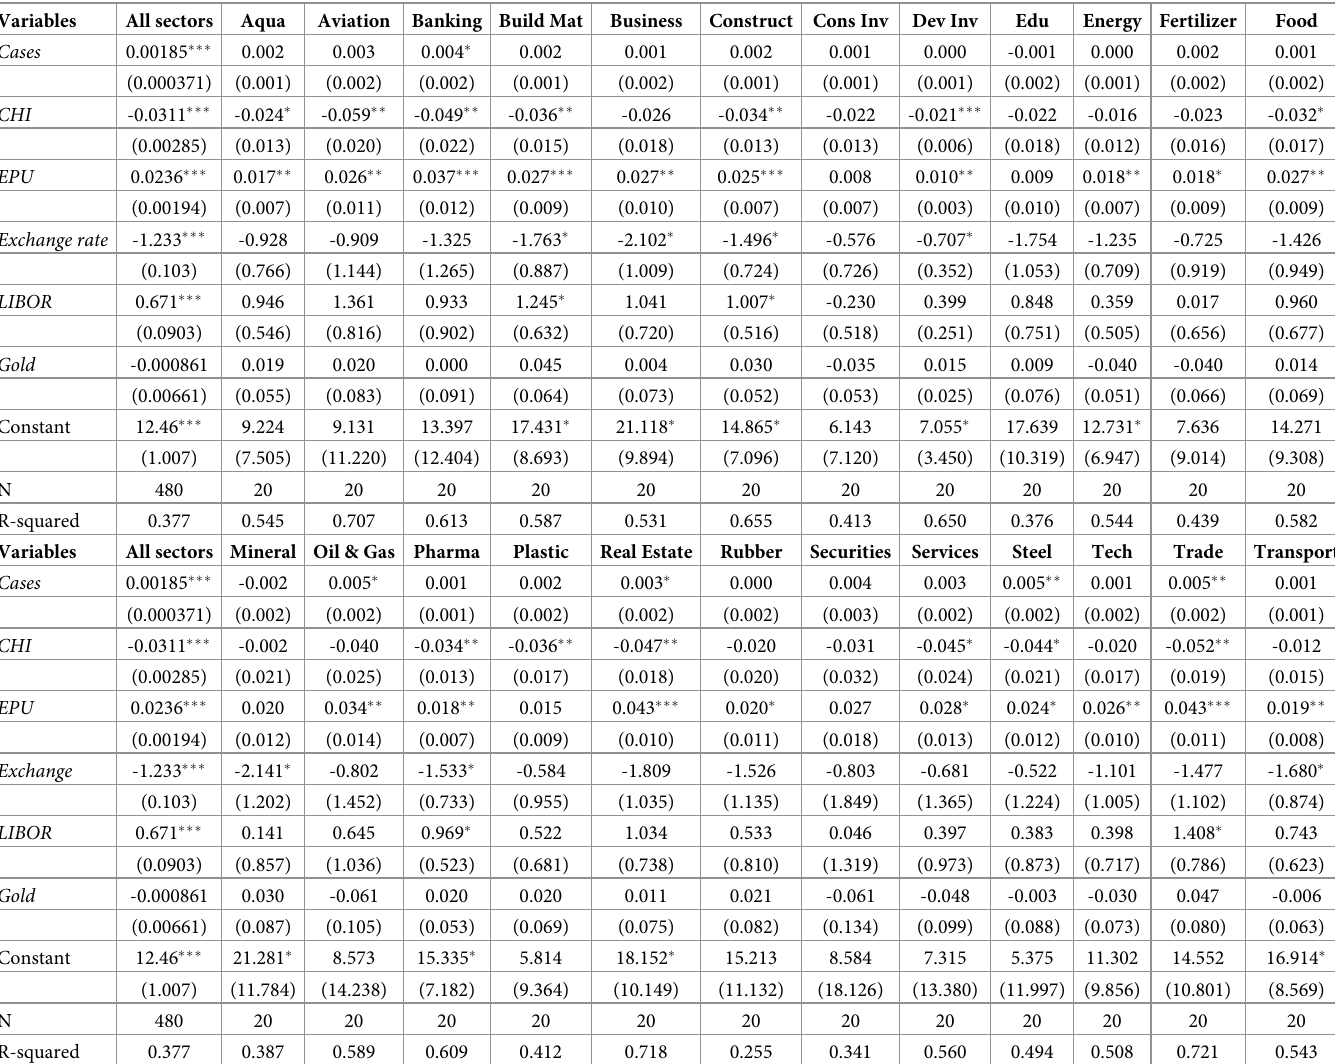
Table 9. The effects of the Covid-19 pandemic, policy responses and macroeconomic fundamentals on the market risks across 24 Vietnamese sectors. Variables All sectors